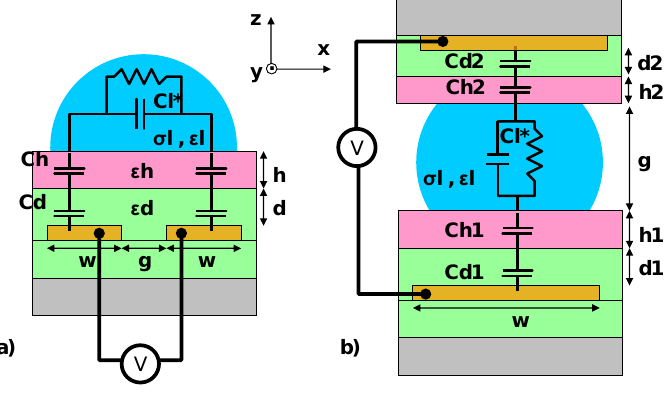
Figure 1. Schematics of a typical device used for LDEP actuation in (a) single-plate open microfluidic device configuration and (b) a parallel-plate closed microfluidic device configuration. The parameters of all the layers are summarized in Table 1. The layer in green refers to a dielectric layer; the layer in pink refers to a hydrophobic layer. The liquid is represented in blue and the wafer in grey. The electrodes are patterned in orange.